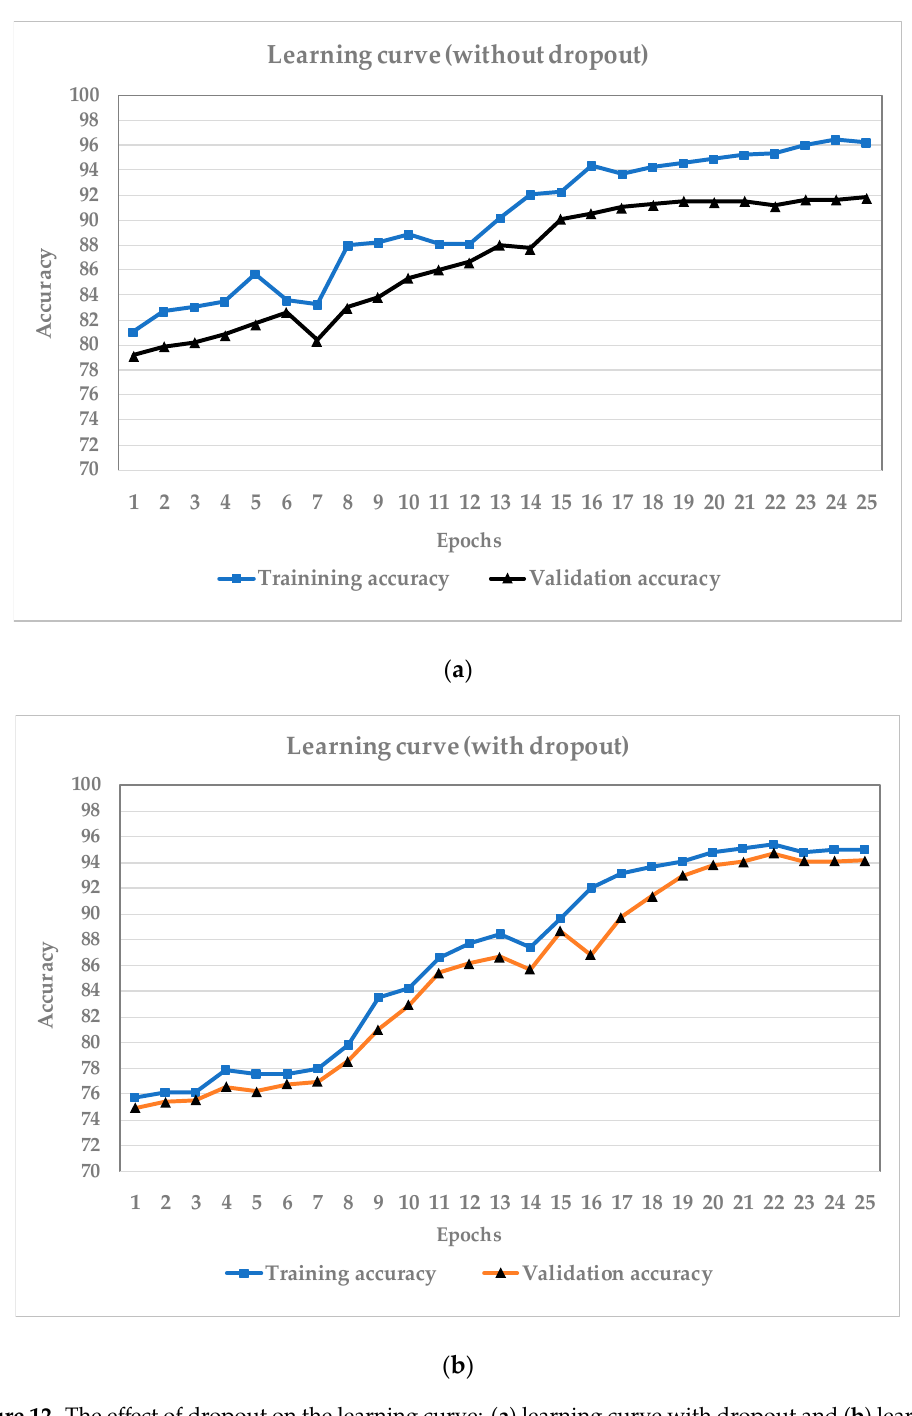
Figure 12. The effect of dropout on the learning curve: ( a ) learning curve with dropout and ( b ) learning curve without dropout.